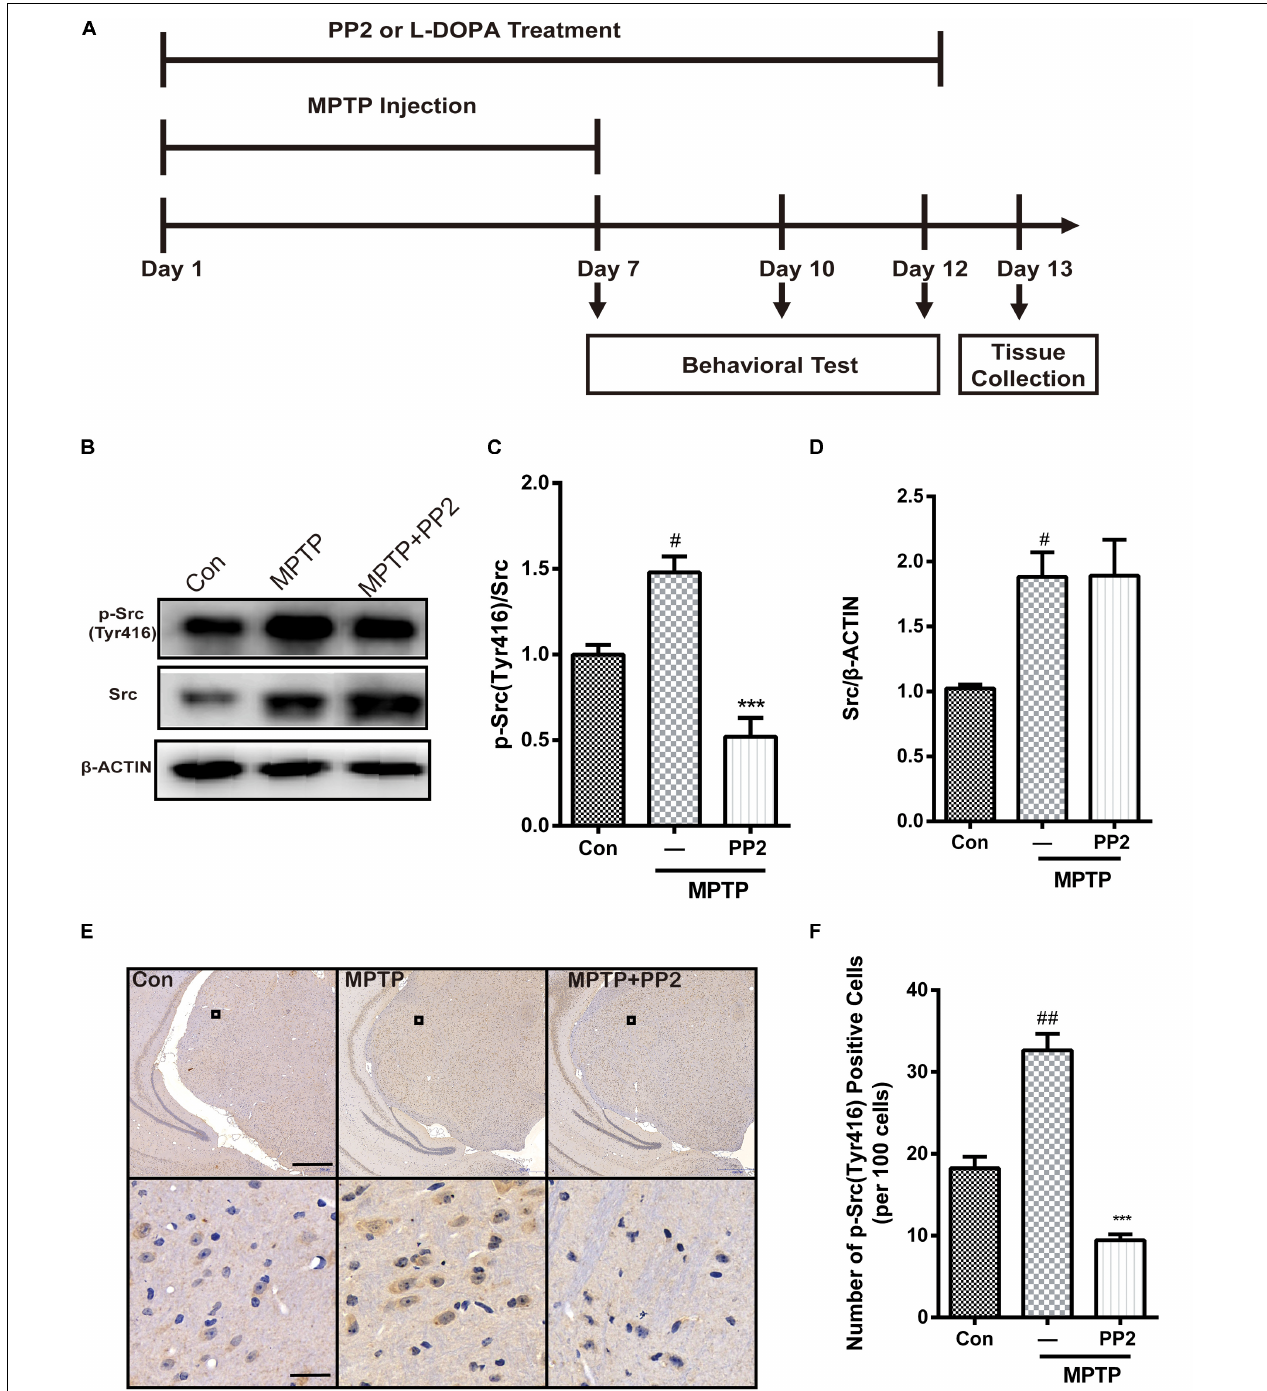
FIGURE 4 | The efficiency of Src inhibitor PP2 was confirmed in 1-methyl-4-phenyl-1,2,3,6-tetrahydropyridine (MPTP)-treated mice. (A) The experimental arrangement. (B–D) The protein level of p-Src and Src in SNpc of MPTP-treated mice was analyzed by western blot with anti-p-Src and anti-Src antibodies. Data are expressed as means ± SEM. n = 4. # P < 0.05 vs. control group,*** P < 0.001 vs. lipopolysaccharide (LPS) group. (E) The brown stain represented p-Src-immunoreactive cells in SNpc (scale bar: top, 600 µ m; bottom, 25 µ m). (F) The number of p-Src-positive cells per 100 cells in SNpc was counted and provided in a histogram. Data are expressed as means ± SEM. n = 4. # P < 0.05 and ## P < 0.01 vs. control group, ** P < 0.01 and *** P < 0.001 vs. MPTP group.